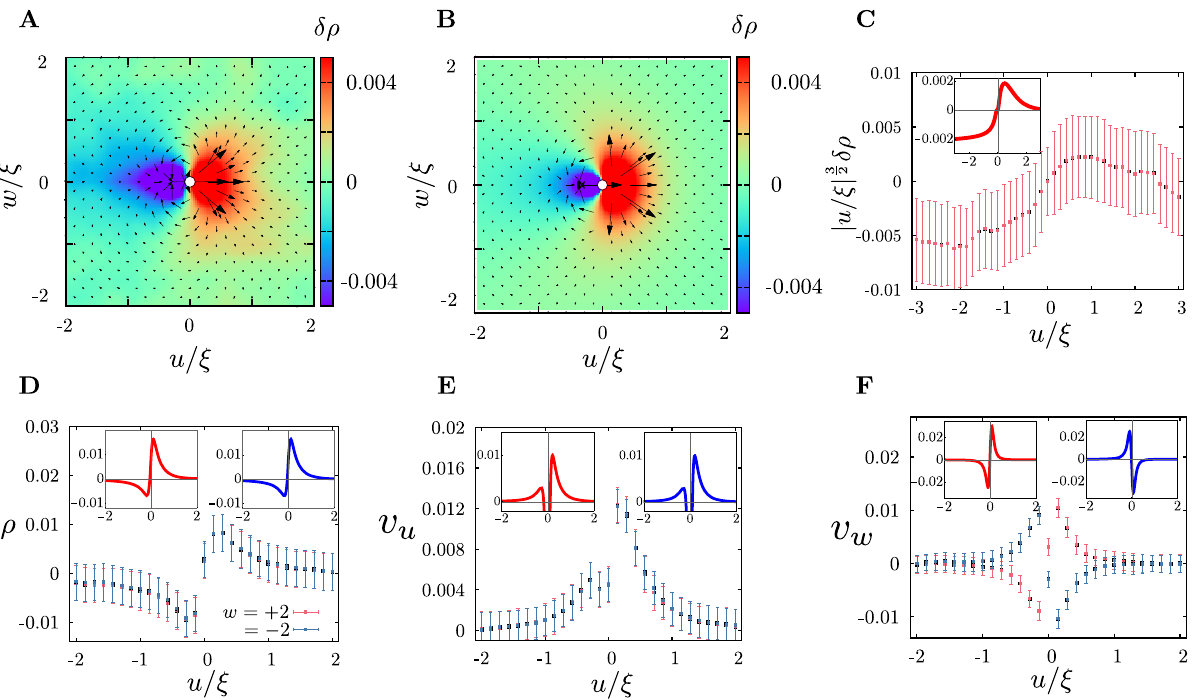
Fig. 6 | Density pro fi le and fl ow fi eld surrounding a single active particle moving through the passive medium. A Density pro fi le (heat map) and velocity fl ow fi eld (arrows, scaled for better visualisation) of the medium from simulations (intheco-movingframe( u , w )scaledbythedecaylength ξ ≈ 14)at ϕ =0.45, T =0.1, f =2.0,and τ → ∞ . B Correspondingdensitypro fi le(heatmap)andvelocity fl ow fi eld (arrows,scaledforbettervisualisation)ofthemediumobtainedfromthelinearised hydrodynamic theory. C The linearised theory (inset) predicts that the excess density of the passive medium is fore-aft asymmetric and shows an exponential decay in front and an algebraic decay behind the moving active particle, which is